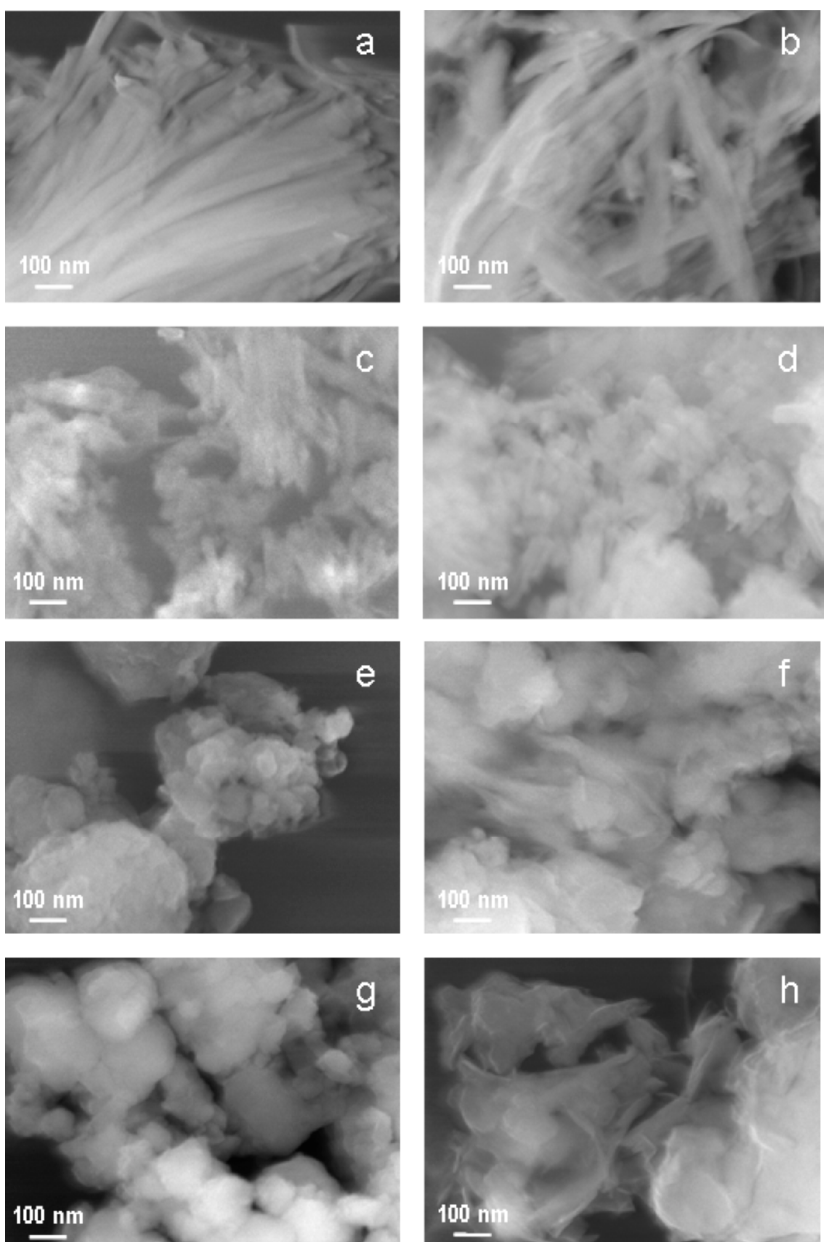
Figure 2. SEM images of: ( a ) Sep, ( b ) Sep/NaOH-24 h, ( c ) Sep/gr-10’, ( d ) Sep/gr-10’/NaOH-24 h, ( e ) Sep/gr-30’, ( f ) Sep/gr-30’/NaOH-24 h, ( g ) Sep/gr-60’, ( h ) Sep/gr-60’/NaOH-24 h.